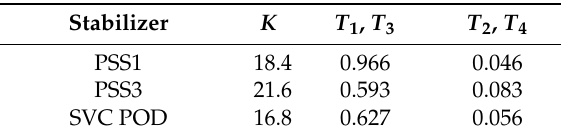
Table 4. The oscillation modes with PSSs and SVC POD.